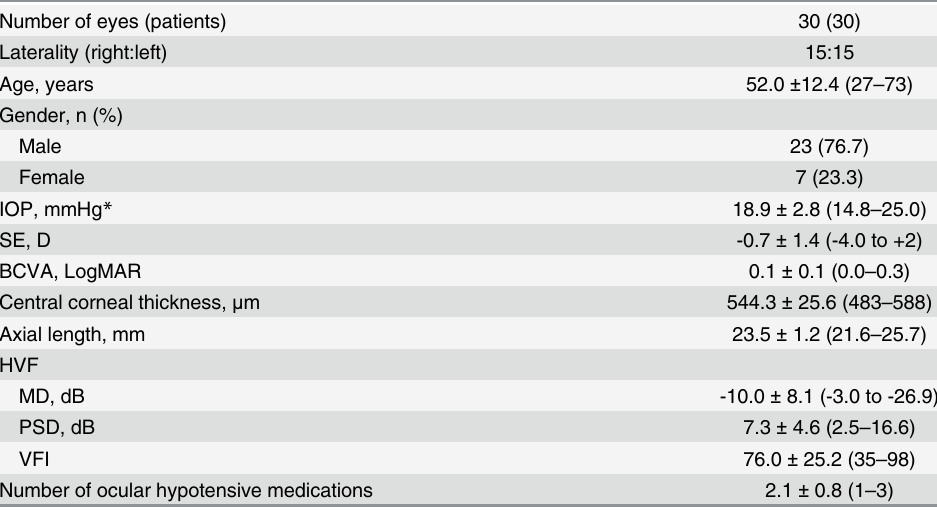
Table 1. Baseline Characteristics of